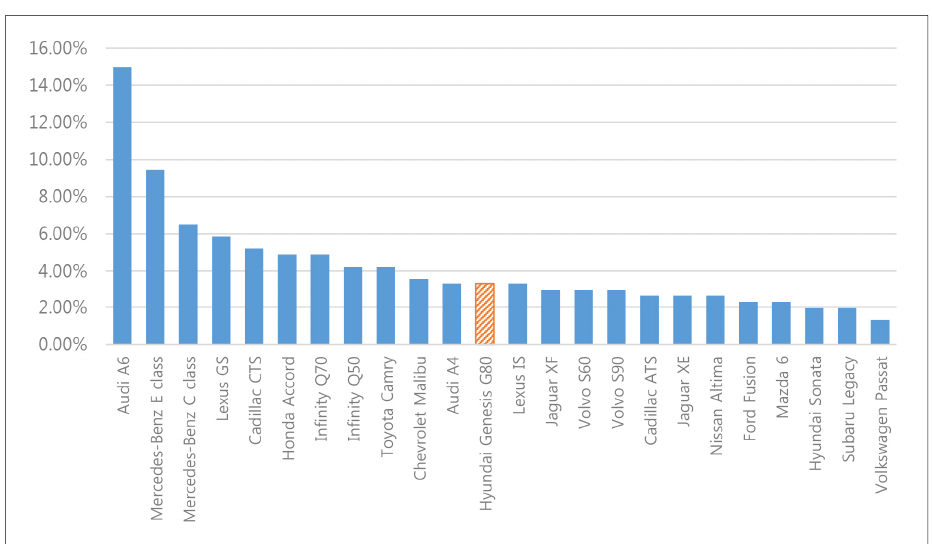
<Figure 8> Frequencies of brands compared with BMW 5-series